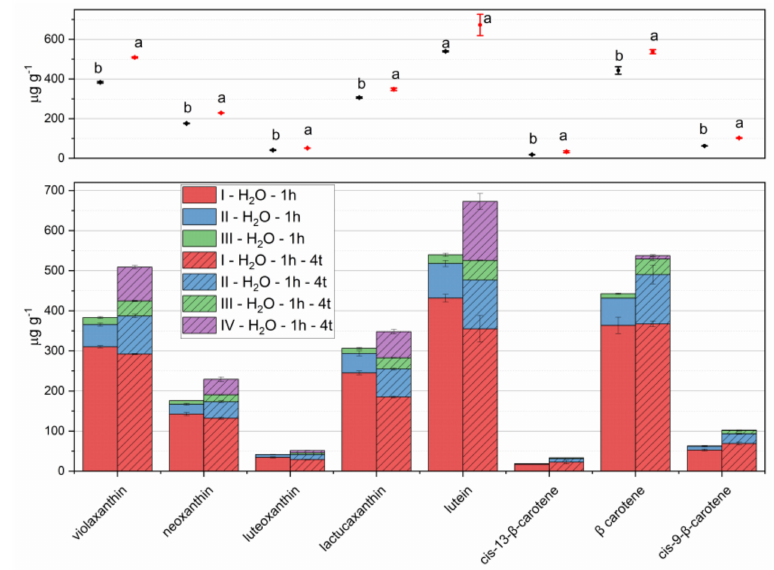
Figure 4. Carotenoids extracted from lettuce microgreens with three repeated 1-hour extraction steps (I–III in left stacked bars, steps I and II with 5 mL of pure acetone, step III with 5 mL of acetone 70%); with four repeated 1-hour extraction steps (I–IV in right stacked bars, step I with 4 mL of